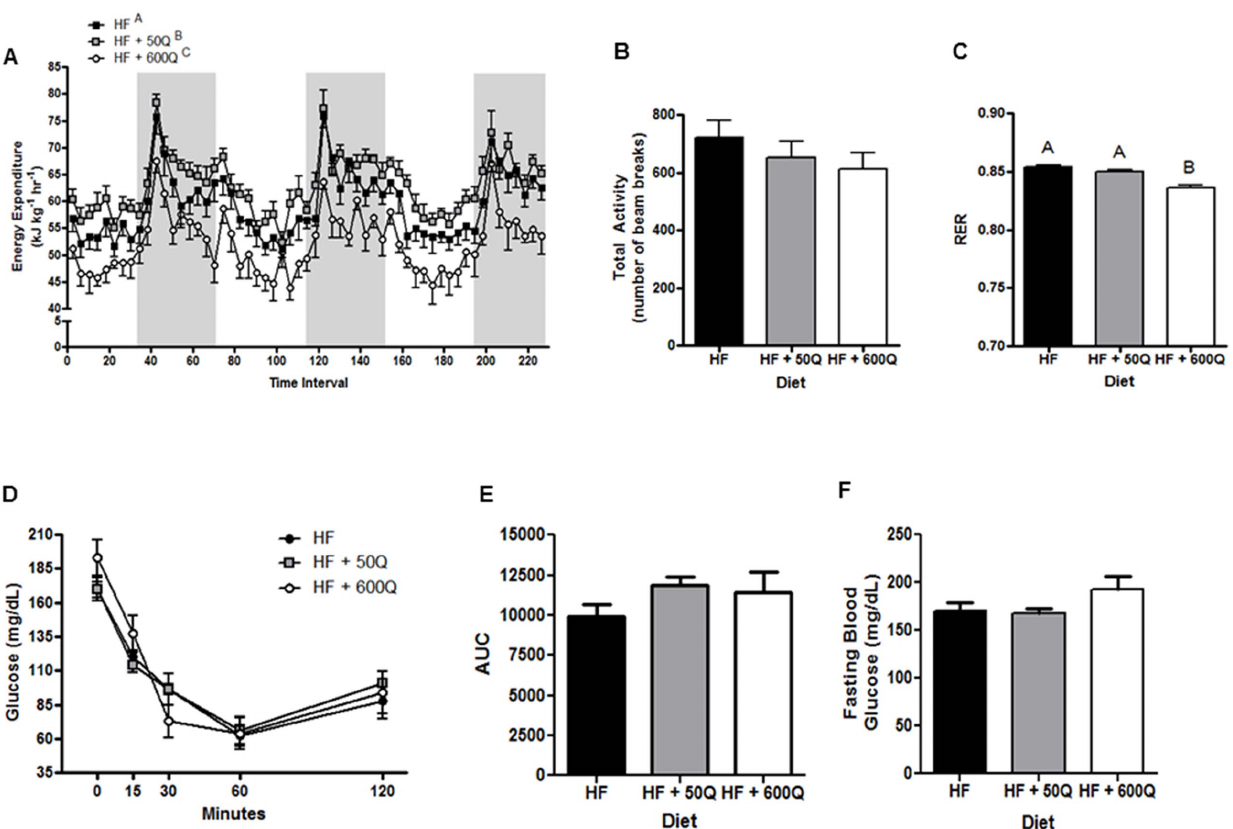
Figure 2. Energy expenditure (A), physical activity (B) and respiratory exchange ratio (RER) (C) were measured by indirect calorimetry in C57BL/6J mice after 3 wks of feeding respective diets. Gray bars represent night periods in A. Significant differences between groups are denoted by differing superscripts. Insulin sensitivity was assessed by measuring blood glucose levels before and during an insulin tolerance test after 3 wks on respective diets. Data are presented before, and at 15, 30, 60 and 120 mins after injection of insulin ( D ) and as the area under the curve (AUC) for each treatment group ( E ). ( F ) Fasting blood glucose levels are also reported. All values are shown as the mean 6 SEM.